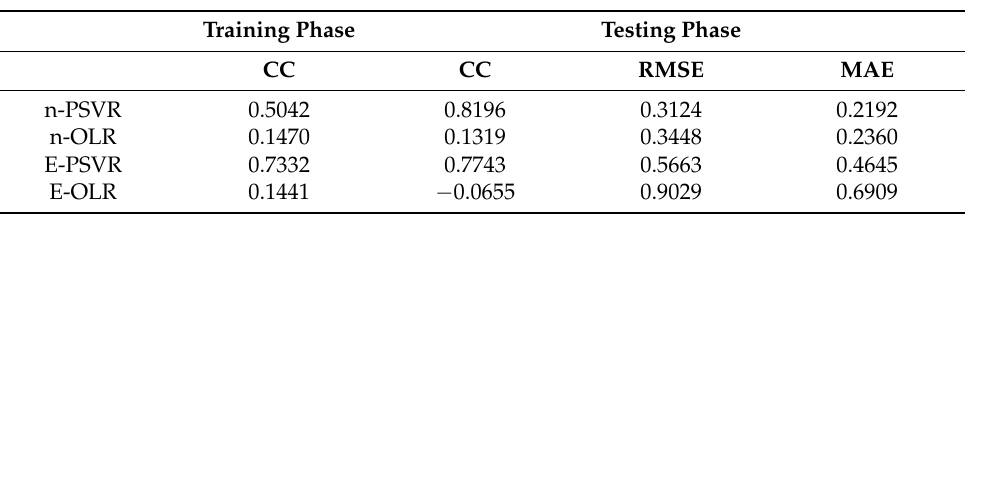
Table 2. Performance evaluations of the developed